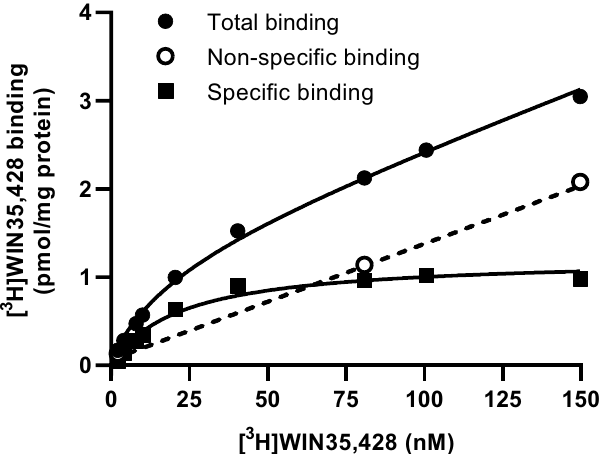
Figure 3. Representative saturation binding curve of [ 3 H]WIN35,428 to DAT on U2OS-DAT membranes. Total binding ( ) and non-specific binding ( ○ ) were determined in the absence or presence of 100 μM GBR12909. Specific binding ( ■ ) was obtained by linear subtraction of non-specific binding from total binding. Data are ● shown as the mean of a representative graph of three separate experiments each performed in